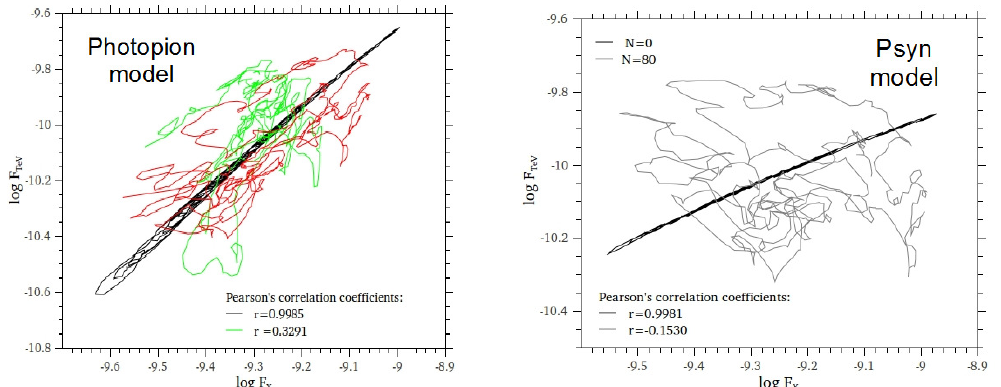
Figure 3. TeV γ -ray flux vs. X-ray flux as obtained in the LH π (left panel) and LHs (right panel) models by varying the injection luminosity of primary electrons and protons. We considered the cases of uncorrelated variations (green line), as well as of correlated variations with no time-lag (black lines) and a positive time-lag of 80 t cr (red and grey lines in the left and right panels,